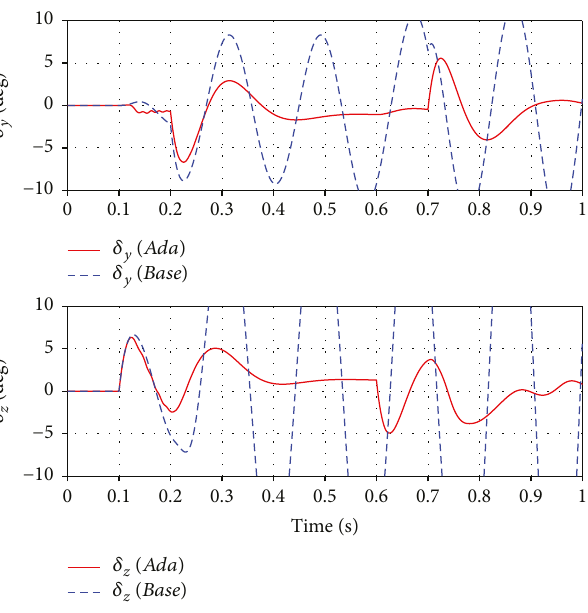
Figure 7: The uncertain case control